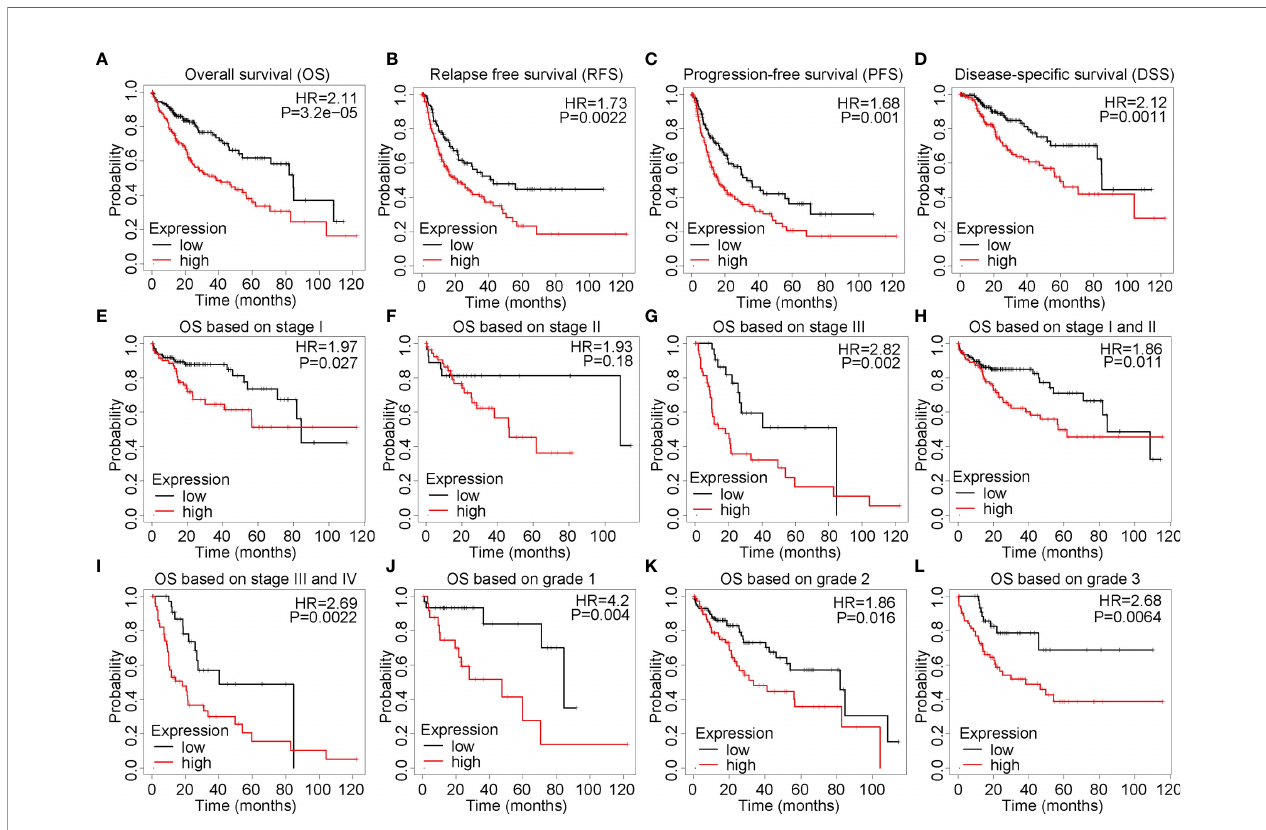
FIGURE 2 | Elevated ALYREF expression and poor prognosis in liver hepatocellular carcinoma. (A – D) A Kaplan-Meier analysis was used to assess ALYREF- associated prognosis, and the results indicated good prognostic values for ALYREF in OS, RFS, PFS, and DSS. (E – L) Kaplan-Meier analyses representing differences in OS in the various patient subgroups based on clinical staging and grading.